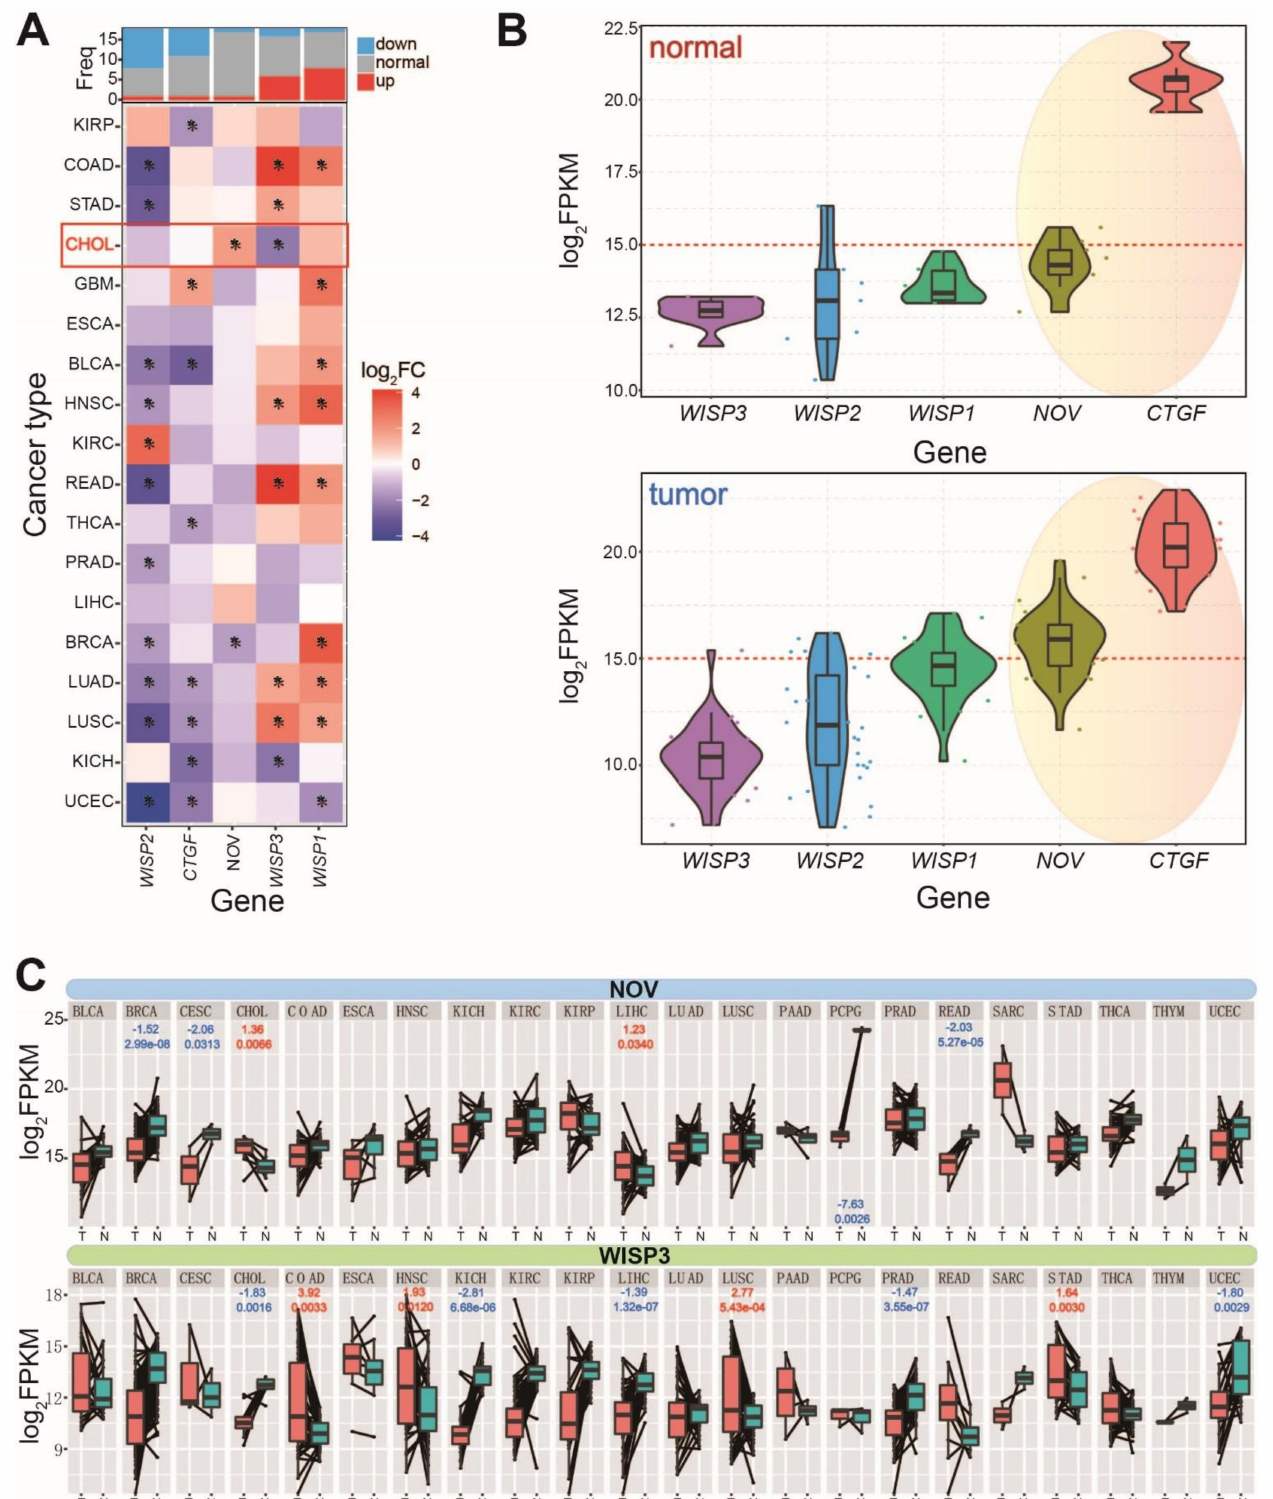
Figure 1. Pan-cancer analysis of expression pattern of CCN gene family. ( A ) Expression distributions of homologous genes in the CCN gene family. * indicates significantly deregulated genes (|log 2 FC| > 1.5, padj < 0.05). ( B ) Expression patterns of five genes in normal and tumor samples in CHOL. ( C ) Paired analysis of deregulated NOV and WISP3 across diverse cancer types. The abnormally expressed genes are presented (|log 2 FC| > 1.2, padj < 0.05 for paired